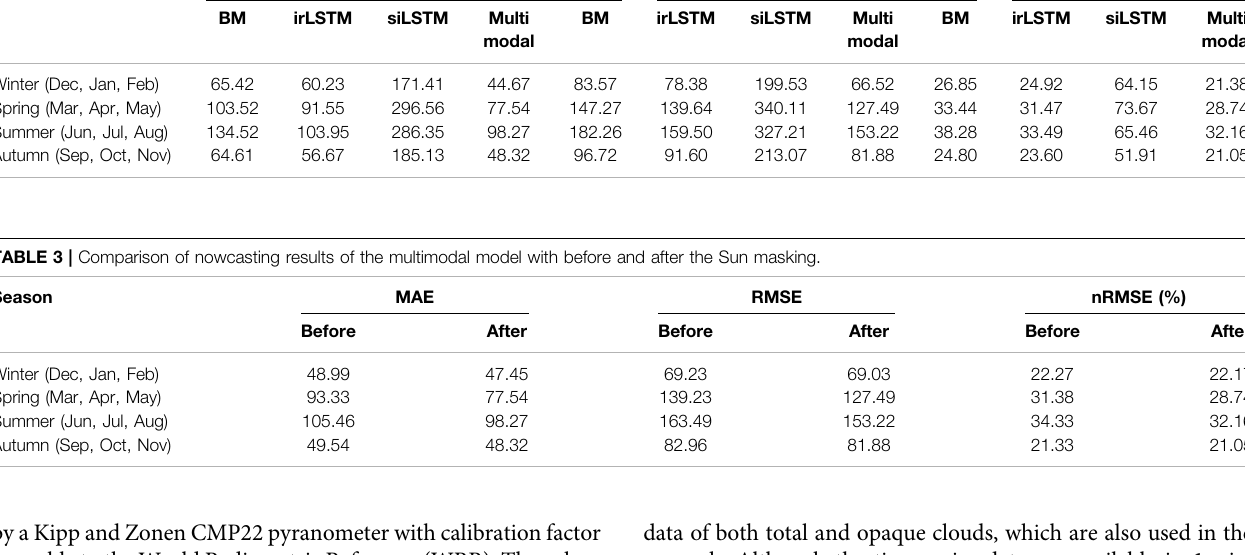
TABLE 2 | Comparison of nowcasting results for benchmark (BM), irLSTM, siLSTM and multimodal models. Season MAE RMSE nRMSE (%)